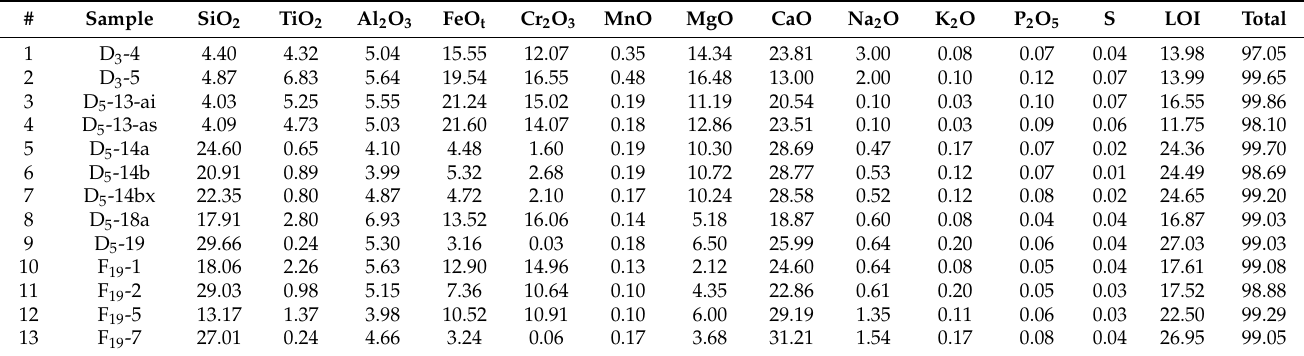
Table 1. Bulk chemical composition of the Sabantuy chromite paleoplacer sandstones and ores (wt.%).